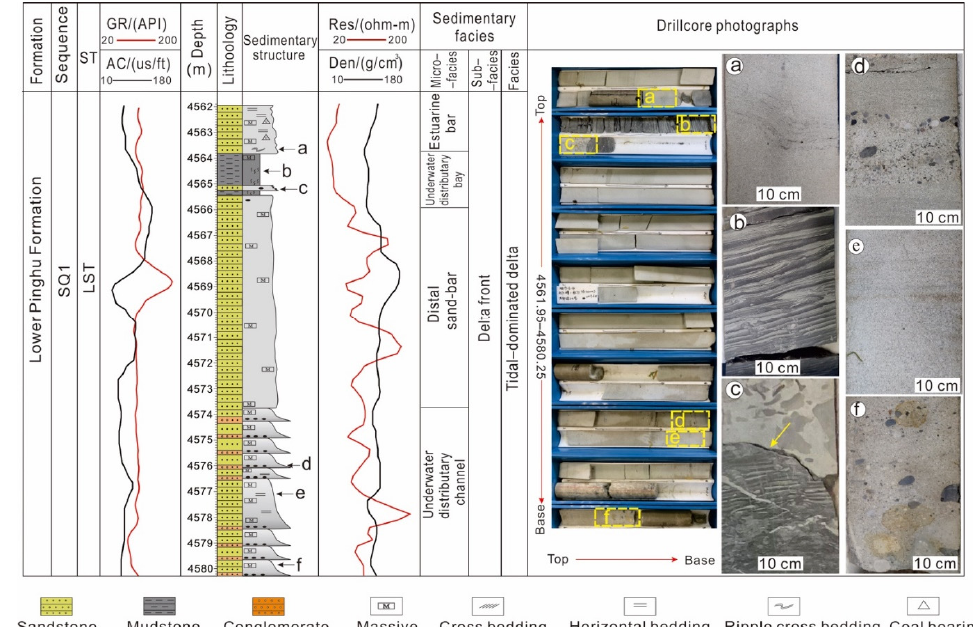
Figure 11. Well log, drill core, and facies interpretations for borehole W-4 in the Xihu Depression. Core photographs at ( a ) 4690.50, grey massive mudstone with developed oblique bedding. Oil stains can be observed; ( b ) 4690.97 m, conglomerate with the size of the gravel decreasing upwardly; ( c ) 4693.59 m coal-bearing mudstone; ( d ) 4695.46 m, abundant plant fossils in mudstone; ( e ) 4696.38 siltstone interbedded black mudstone with developed ripple cross-lamination; ( f ) 4696.38 coal seam (1 cm thick) bearing mudstone.